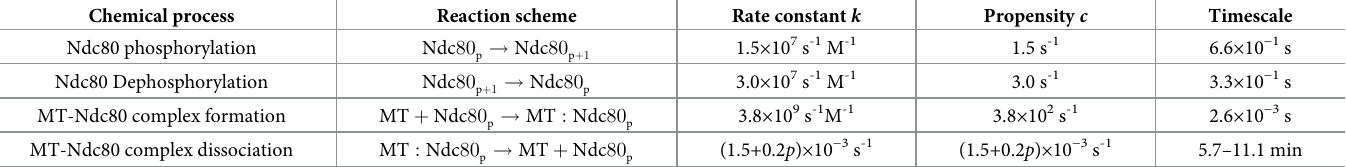
Table 4. Biochemical reactions at kinetochore-microtubule interface. Enzymatic reactions (e.g., phosphorylation and dephosphorylation) and association-dissociation reactions, which involve the MT associated protein Ndc80 linking MTs with KTs, and the reaction rate constants and characteristic timescales. The subscript p = 0, 1, ... ,6 denotes the number of phosphate groups attached to Ndc80 and changes in the rate constants and reaction propensities for MT-Ndc80 complex dissociation. Chemical process